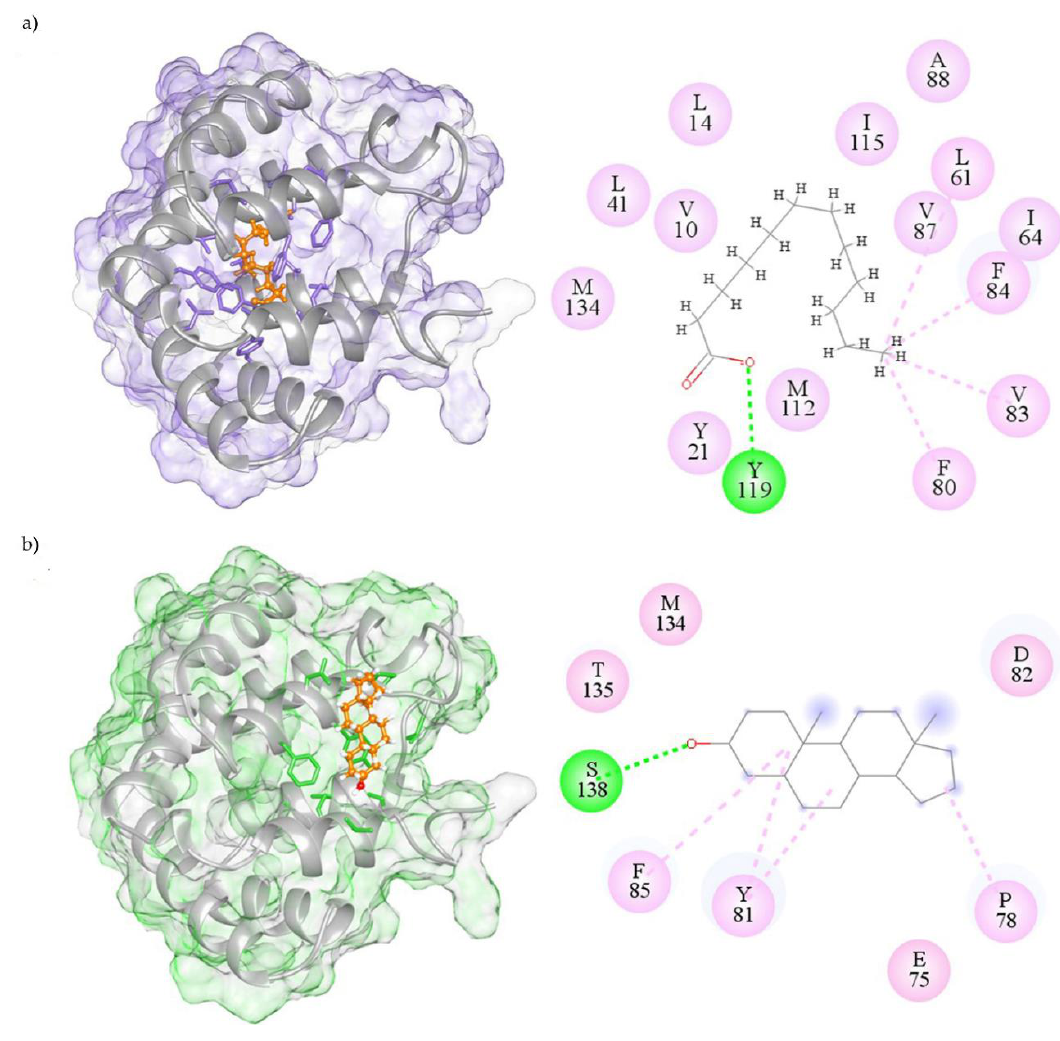
Figure 3. Molecular residue interactions of Fel d 1 with the best ligands, lauric acid ( a ) and androstenone ( b ). The interactions are shown in molecular ligand binding view (surface mesh) with a 2D-interaction map of the selective best-fitting ligands to the central and surface binding cavities of Fel d 1. The 2D map reports H-bond interactions in green color and hydrophobic interactions (van der Waals and alkyl/pi-alkyl) in pink color. All the amino acid residue interactions within 4 Å from the ligand are shown.